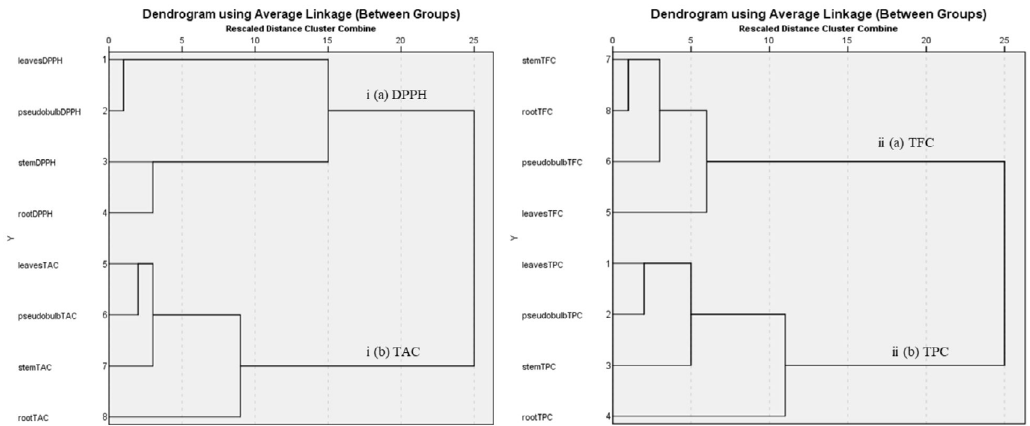
Fig. 4. Hierarchical cluster analysis between (i) DPPH Scavenging activity and TAC, and (ii) TFC and TPC